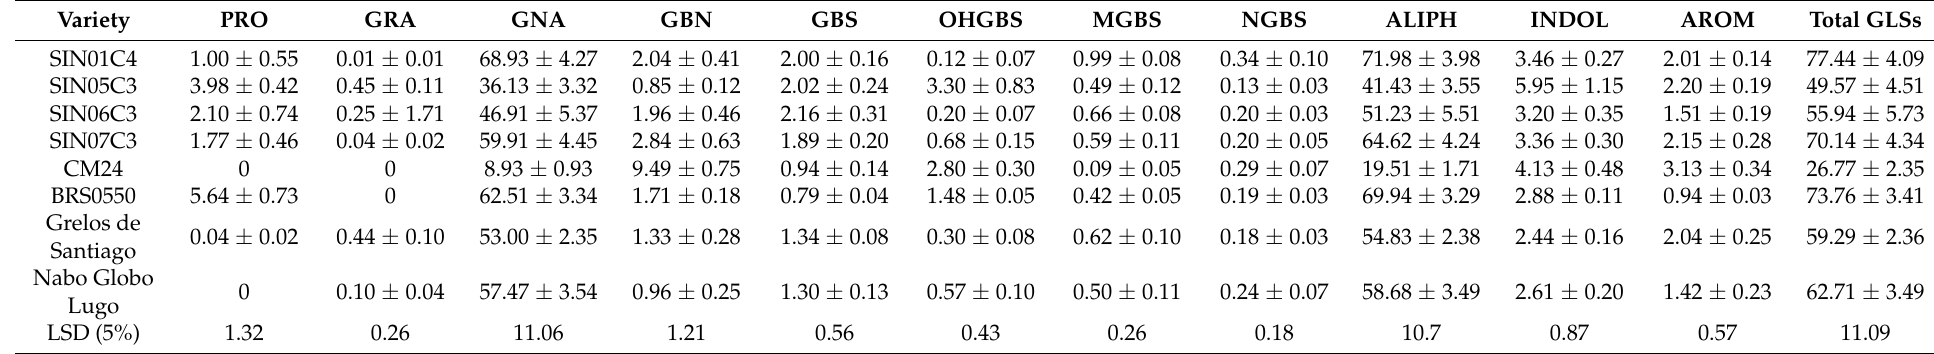
Table 5. Mean ( µ mol gram − 1 dw) glucosinolate content in turnip tops from the B. rapa varieties evaluated at two environments in Northwestern Spain at the growing season 2017–2018.